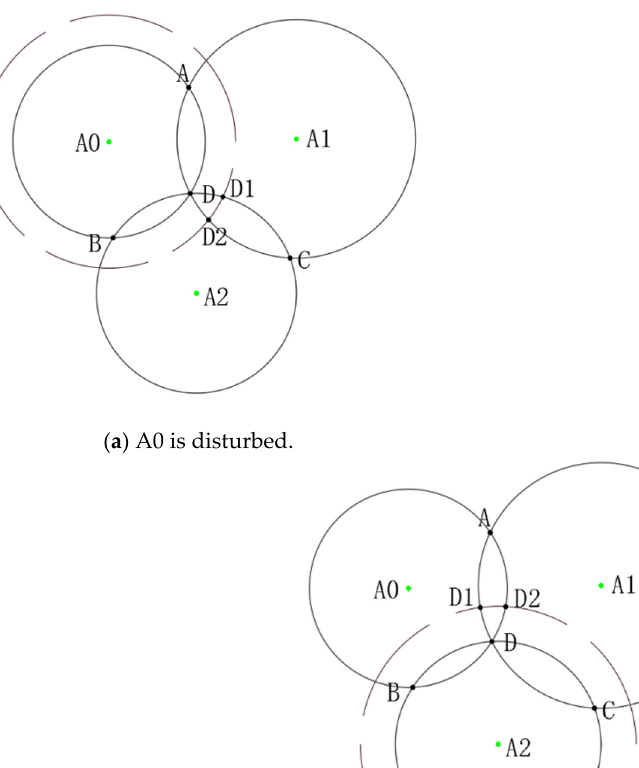
Figure 12. Schematic diagram of abnormal data error. 3.4. Model Accuracy In this paper, one ‐ dimensional, two ‐ dimensional, and three ‐ dimensional RMSE (Root Mean Square Error, root mean square error) are used to evaluate the results and illustrate the validity of the model. The main calculation formulas for each index are as follows [27,28]: